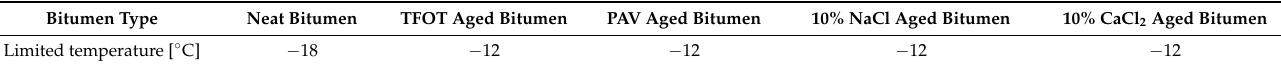
Table 5. The limited temperature of five kinds of bitumen.